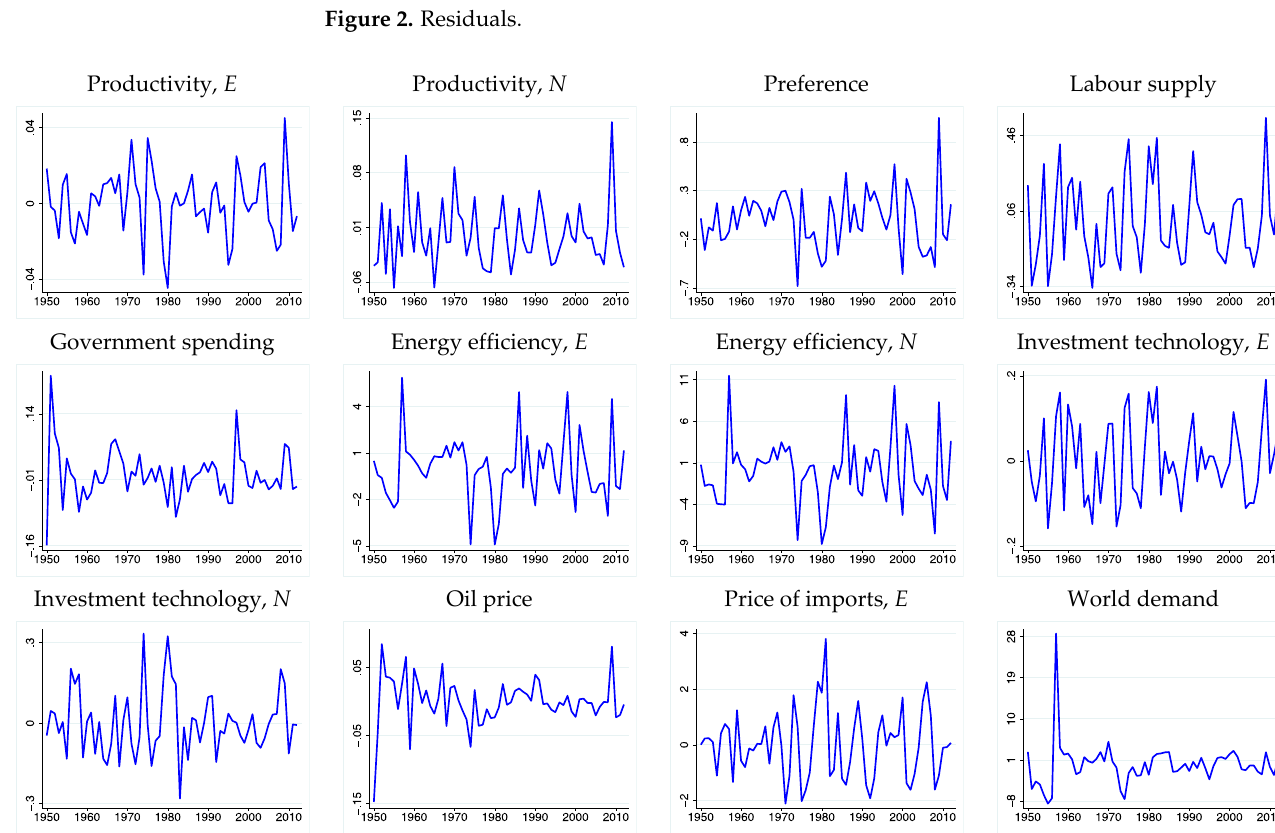
Figure 3. Shocks. Figure 3. Table 2. Estimates of the shock processes by indirect inference.